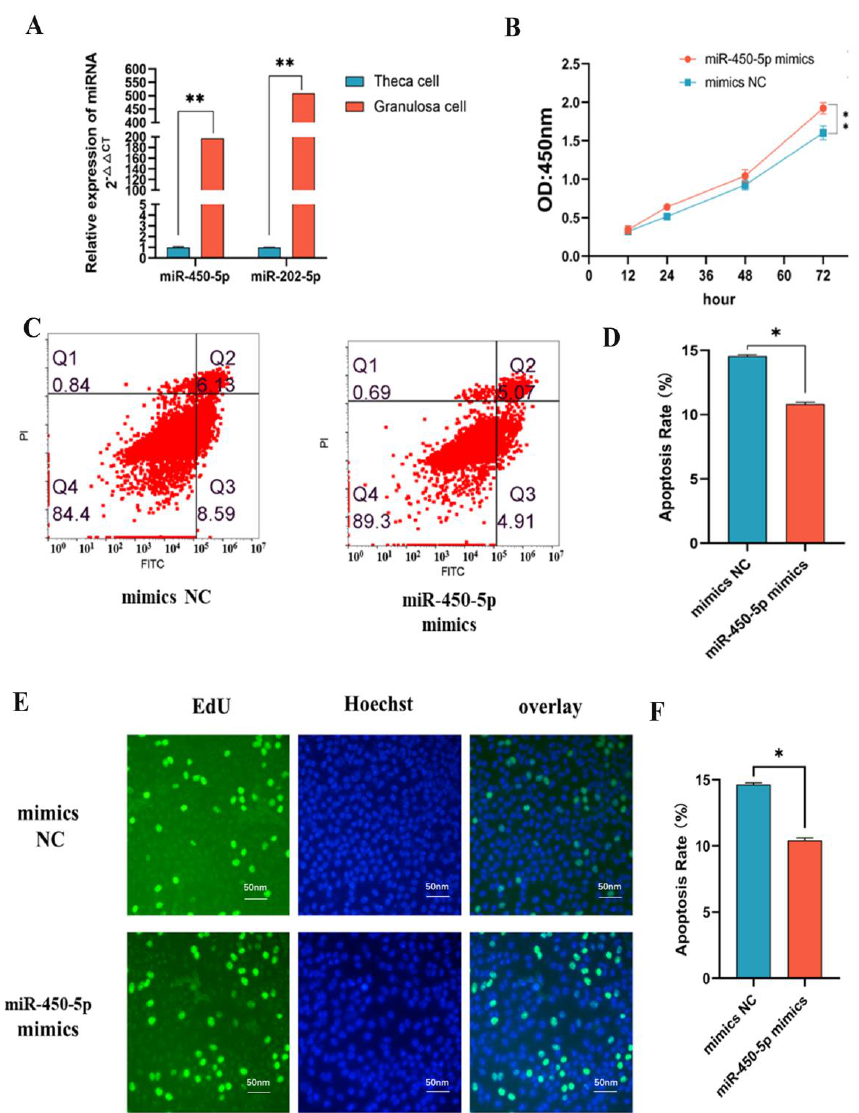
Figure 4. miR-450-5p stimulates the proliferation of GCs. ( A ) Expression of miRNA in follicular granulosa cells versus follicular theca cells. Results are shown as Mean ± SD, n = 4, ** p < 0.01 indicates a highly significant difference. ( B ) CCK8 line graph of miR-450-5p mimics and mimics NC. OD values at 450 nm were determined at 12 h, 24 h, 48 h, and 72 h. (Mean ± SD, ** p < 0.01). ( C , D ) Results of flow apoptosis measurements of miR-450-5p mimics versus mimic NC with apoptotic cells as a percentage of all cells. (Mean results ± SD, * p < 0.05 indicates significant difference). ( E , F ) EdU cell proliferation assay. Comparison of miR-450-5p mimics as well as mimics NC in EdU fuel (proliferating cells) as a percentage (%) of hoechst fuel (overall cells). Three replicates per group, mean ± SD,* p < 0.05 indicates a significant